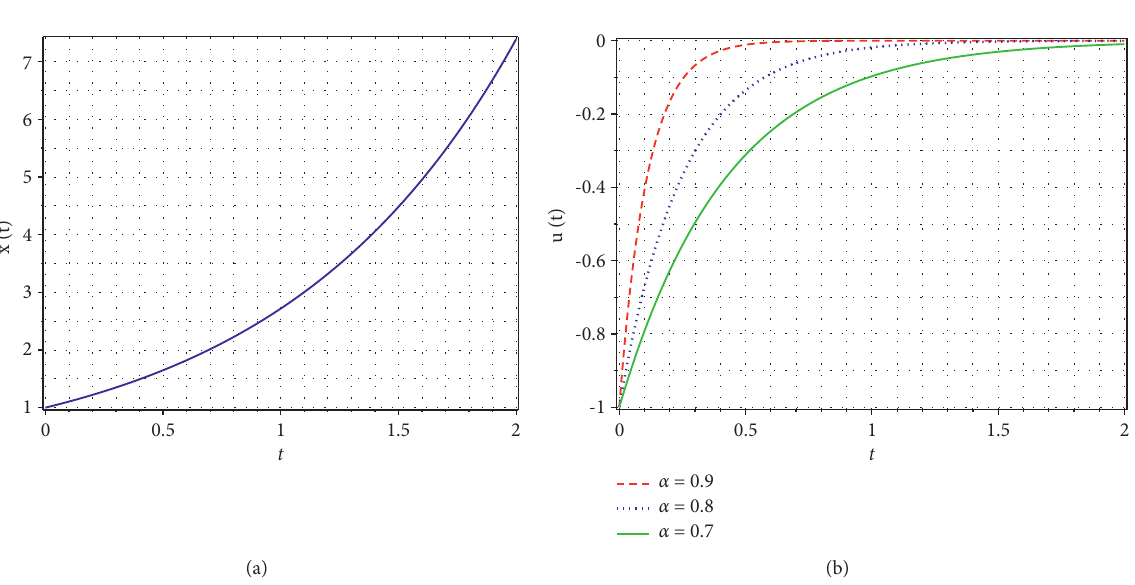
Figure 4: Approximate solutions of x ( . ) and u ( . ) with N � 15 in Example 3. (a) Approximate solution of x ( . ) for α � 0.9. (b) Approximate solution of u ( . ) for α � 0.7, 0.8, and